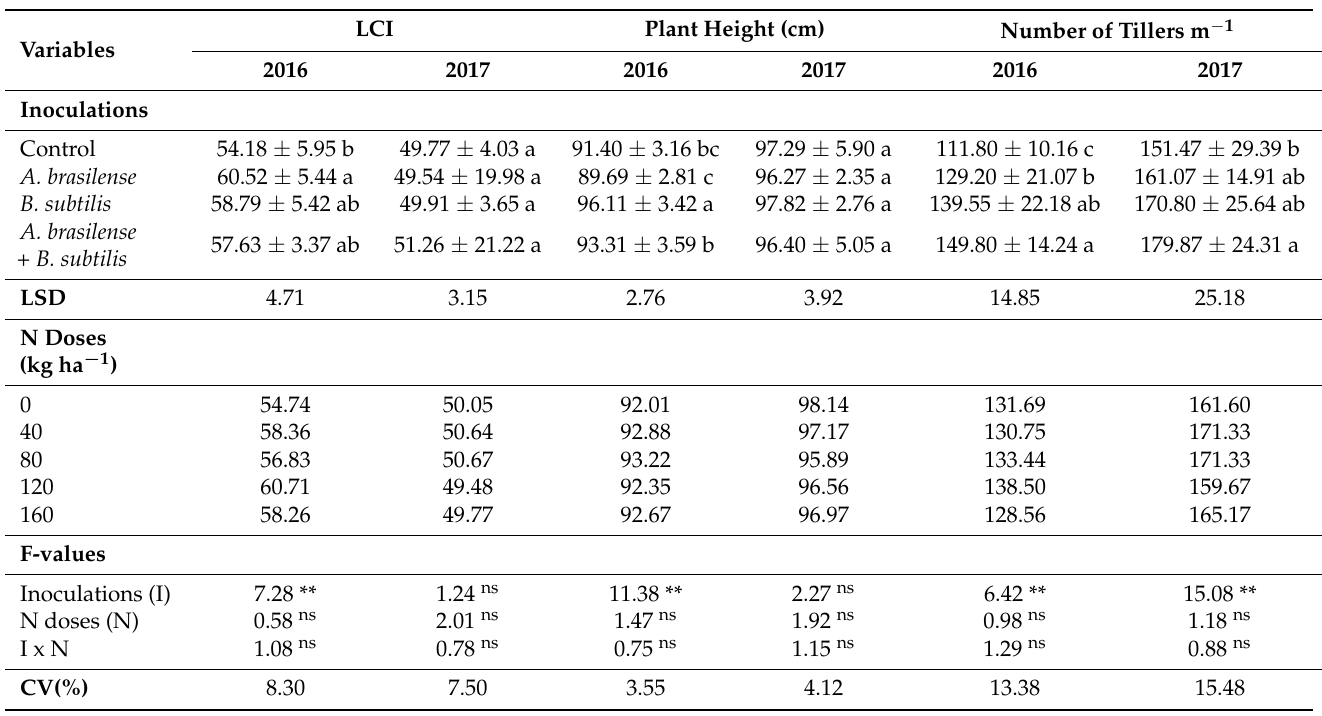
Table 3. Leaf chlorophyll index (LCI), plant height and number of tillers m − 1 of wheat as a function of plant growth-promoting bacteria and N doses in the 2016 and 2017 cropping seasons.